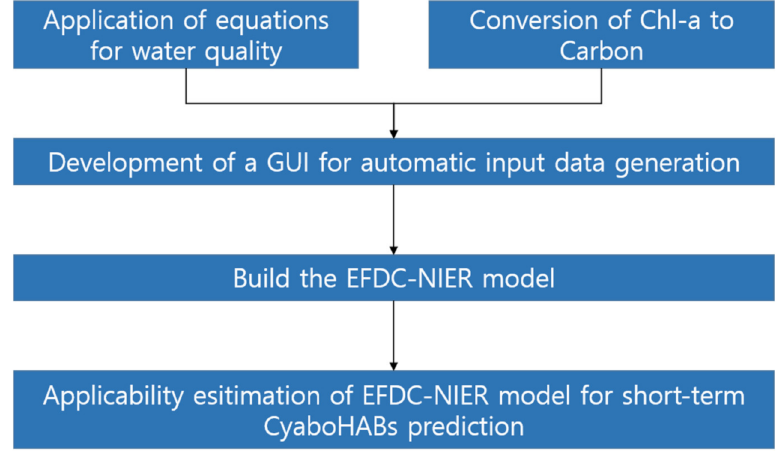
Figure 1. Workflow process of the